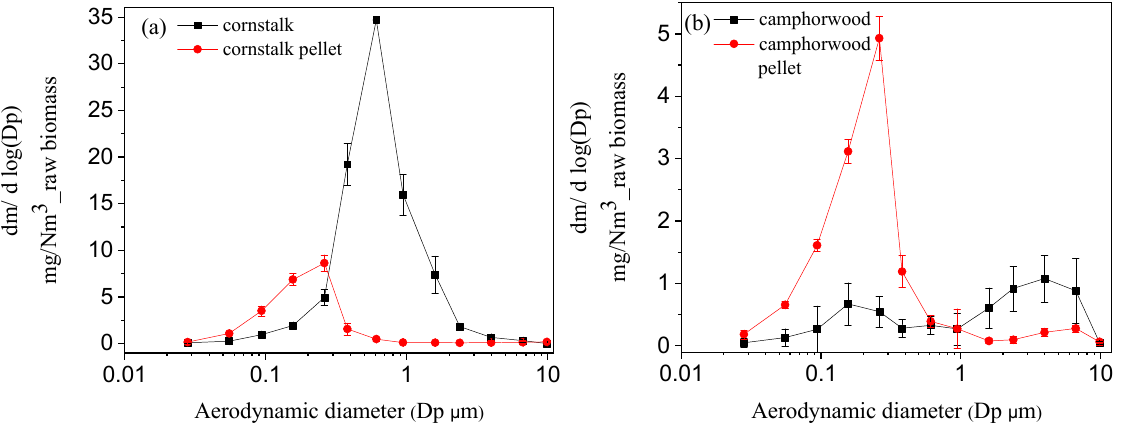
Figure 3. Particle size distributions (PSDs) of PM 10 from biomass combustion. ( a ) cornstalk and cornstalk pellet; ( b ) camphorwood and camphorwood pellet.